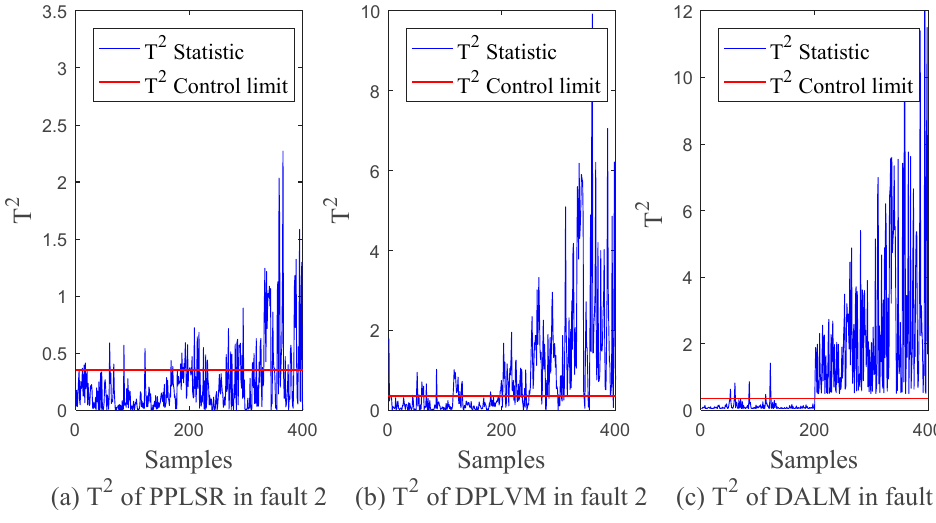
Figure 7. Monitoring results of fault 2. ( a ) T 2 of PPLSR in fault 2; ( b ) T 2 of DPLVM in fault 2; ( c ) T 2 of DALM in fault 2.